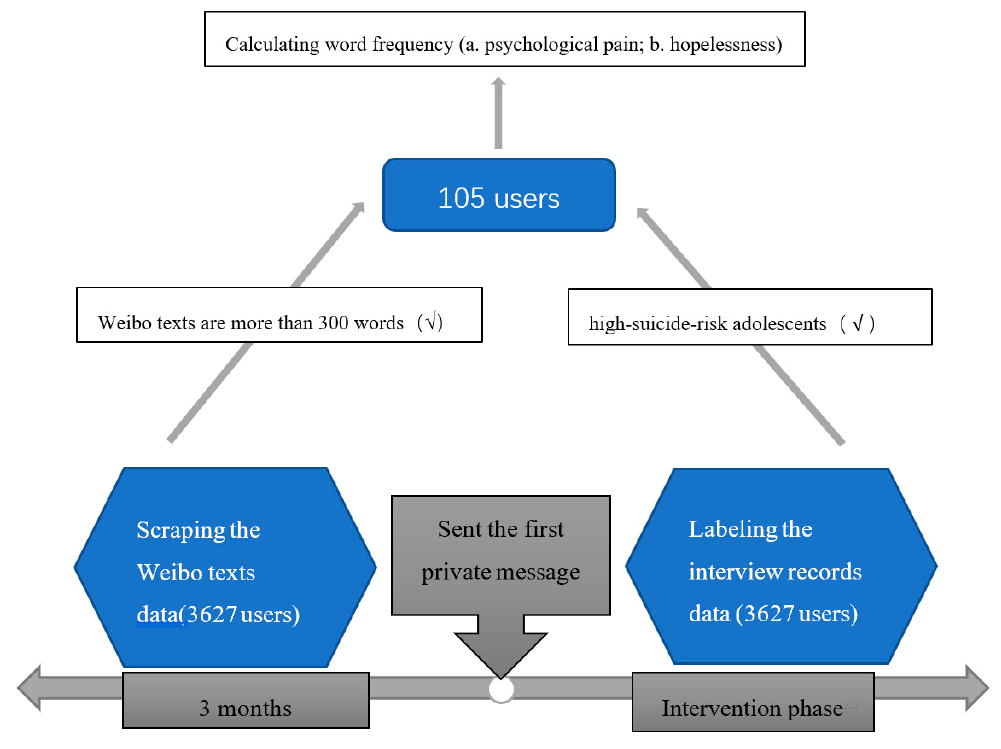
Figure 4. Data acquisition